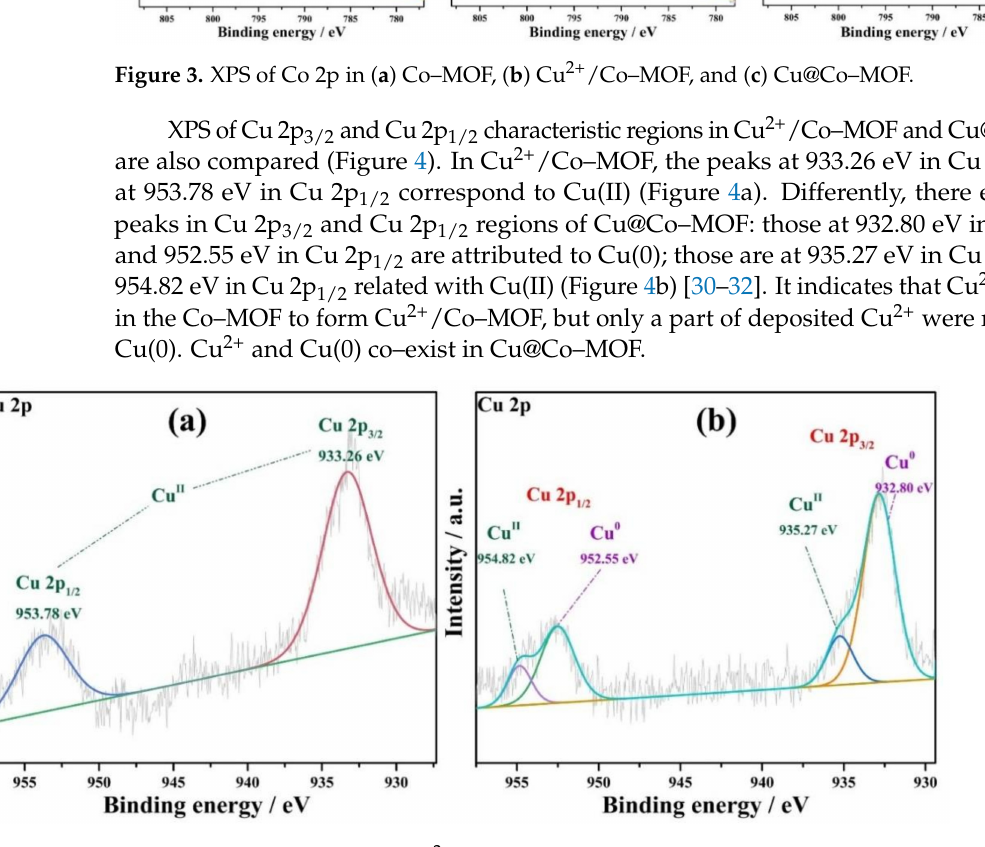
Figure 4. XPS of Cu 2p in ( a ) Cu 2+ /Co–MOF and ( b )